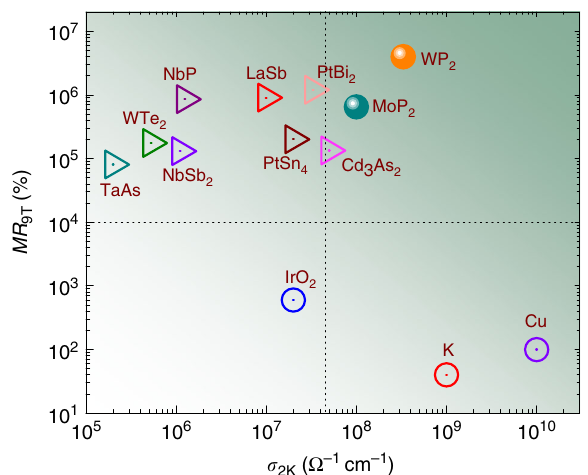
Fig. 5 A comparison of MR and conductivity of some well-known metals and semimetals WP 2 and MoP 2 are placed in the MR -conductivity plane at 2 K and 9 T along with some well-known metals and semimetals for comparison. Semimetals are denoted by triangles, metals by hollow circles and WP 2 and MoP 2 by solid circles. Metals with high conductivity have smaller MR and semimetals with smaller conductivities have larger MR . WP 2 and MoP 2 exhibit both very large conductivity, as well as